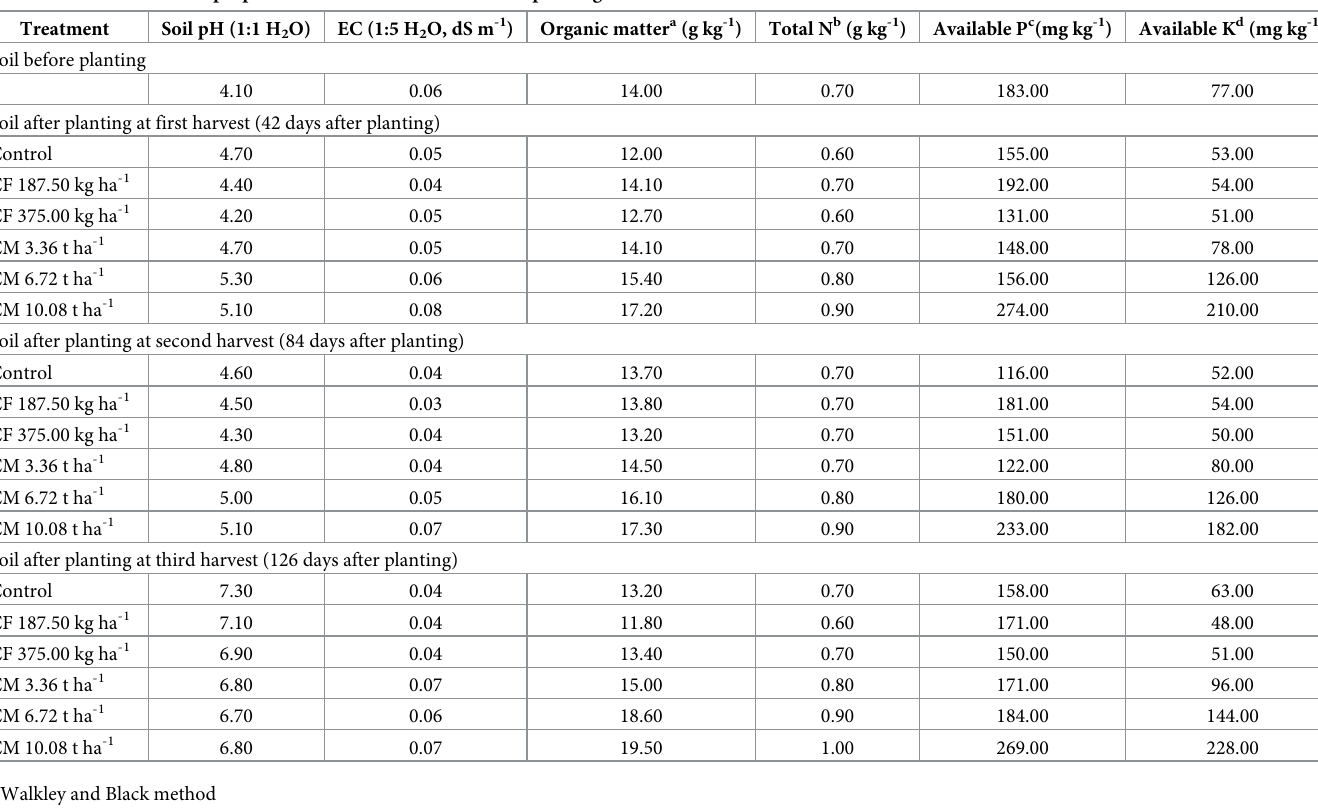
Table 3. Selected chemical properties of the soils before and after planting under the different fertilizer treatments. Treatment Soil before planting Soil after planting at first harvest (42 days after planting)